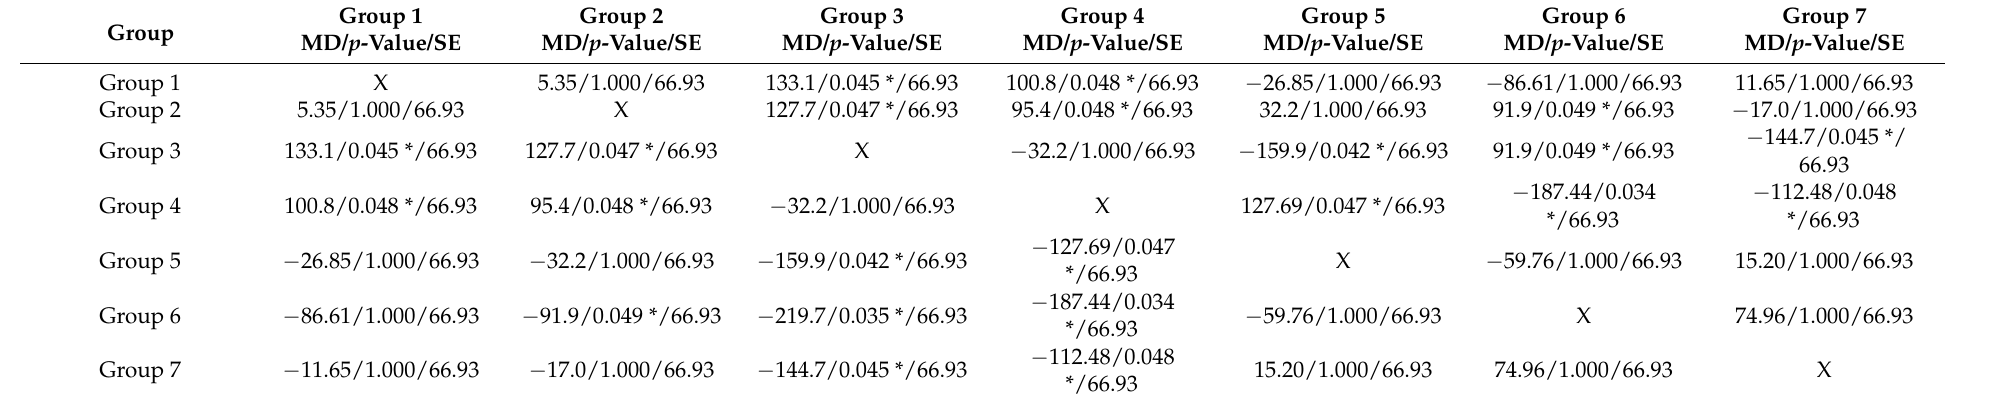
Table 4. Intergroup comparison of mean maximum compressive load (N) assessed using the posthoc Bonferroni